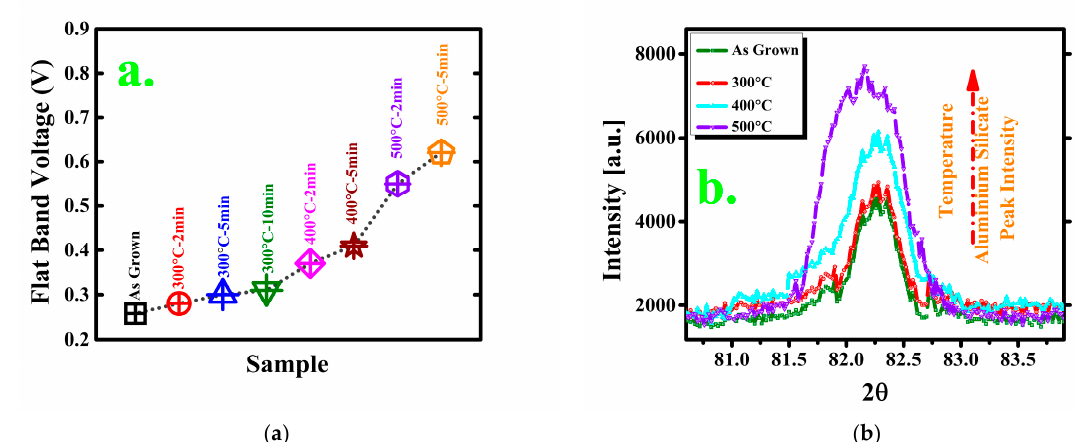
Figure 2. ( a ) Flat-band voltage comparison by inflection point method; ( b ) XRD peak value indicating aluminum silicate presence.